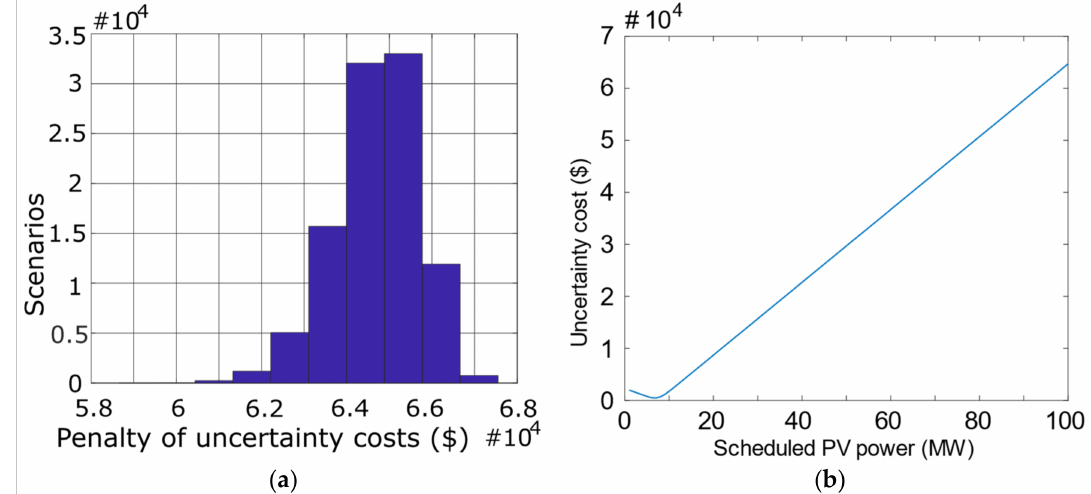
Figure 5. Monte Carlo simulations for ( a ) UC function histogram and ( b ) evaluation of UCs by varying solar power. (# means 10 4 ).